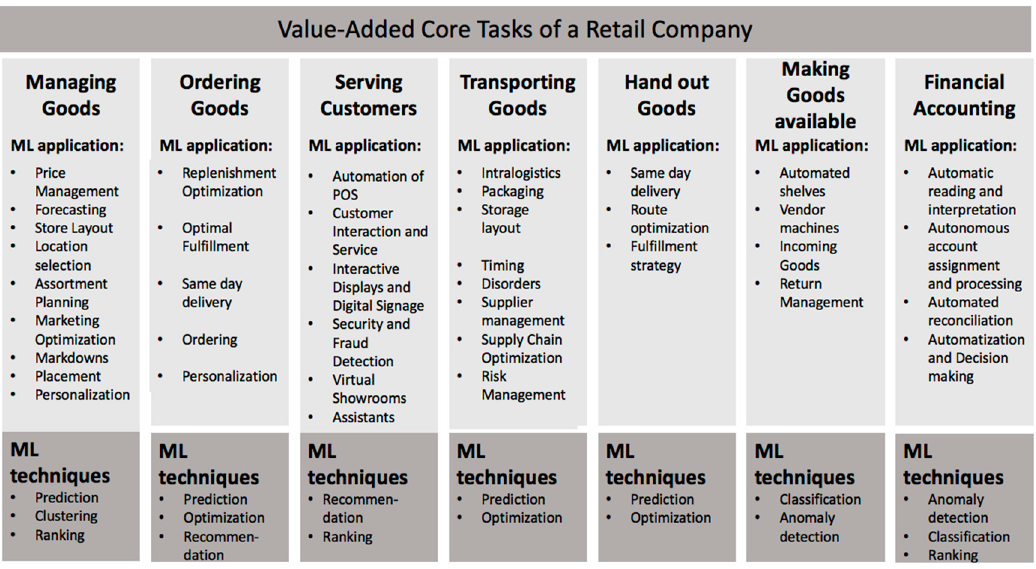
Figure 4. Overview of ML application use-cases and techniques for the value-adding core processes in retailing.